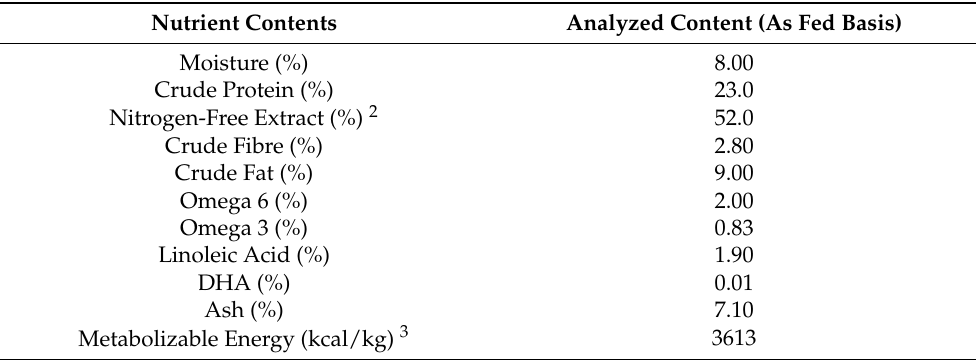
Table 1. Diet nutrient content of SUMMIT Three Meat Reduced Calorie Recipe on an as-fed basis and ingredient composition 1 .